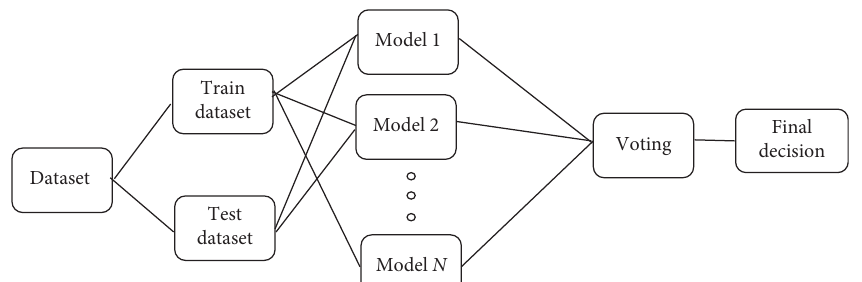
Figure 9: AdaBoost